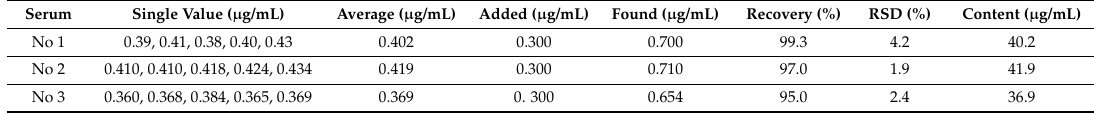
Table 3. Results of samples